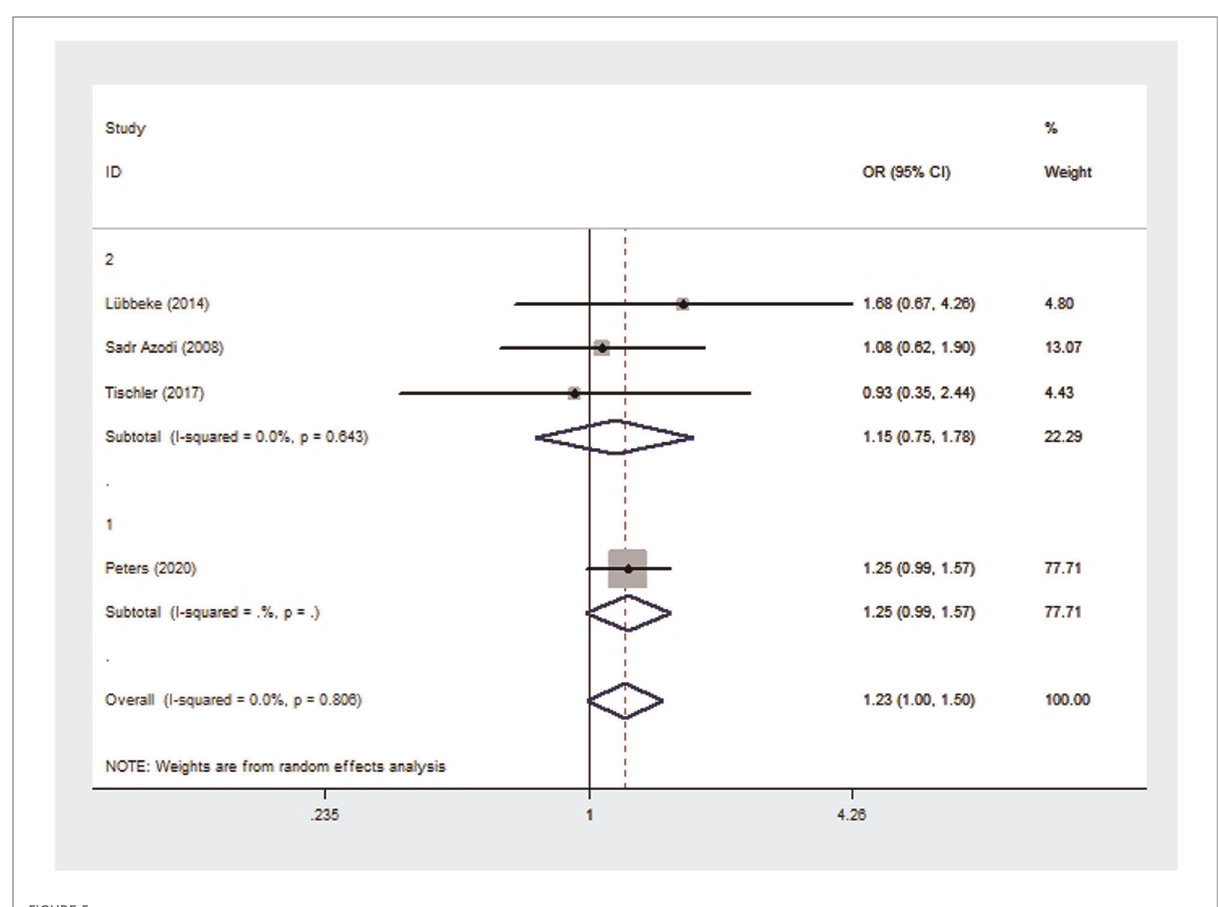
FIGURE 5 Forest plot of subgroup analysis for dislocation based on study type (1: case-control study; 2: cohort